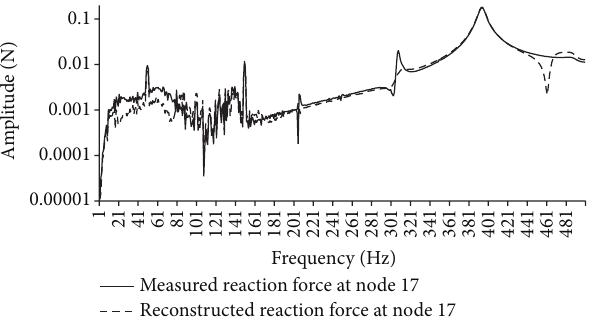
Figure 15: Experimental and estimated reaction force 𝐹 17